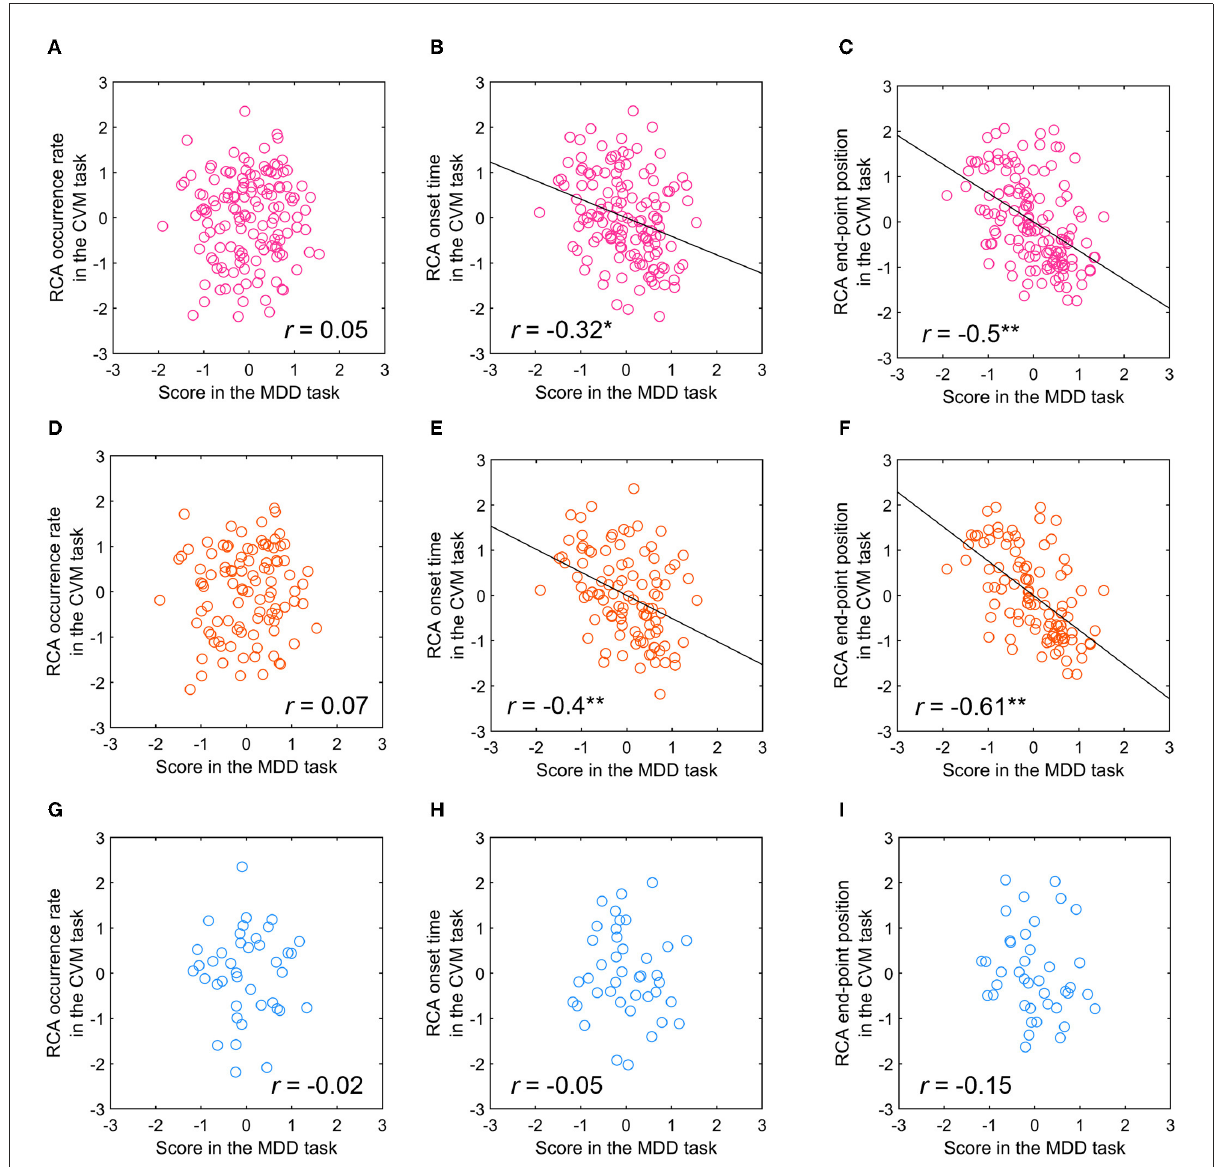
FIGURE11 Relationship between the scores in the MDD task at C70 for the TAV hemifield and RCA occurrence rate, RCA onset time, and RCA end-point position of the CVM task at 5000 pixels/s. (A–C) All participants. (D–F) Participants with more than 8 years of competitive experience. (G–I) Participants with < 8 years of competitive experience. * p < 0.01, ** p <